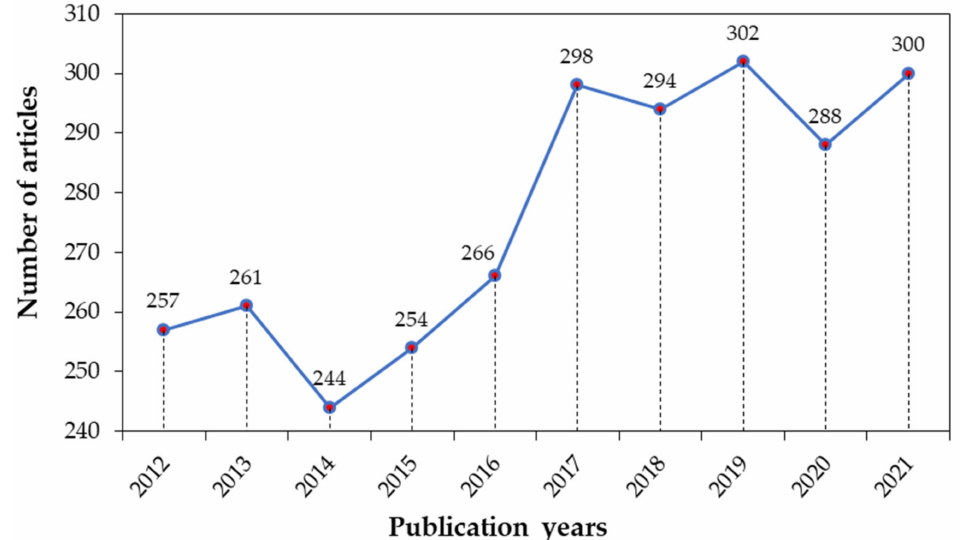
Figure 3. Scientific articles on Odonata available from the Web of Science database, per year of publication